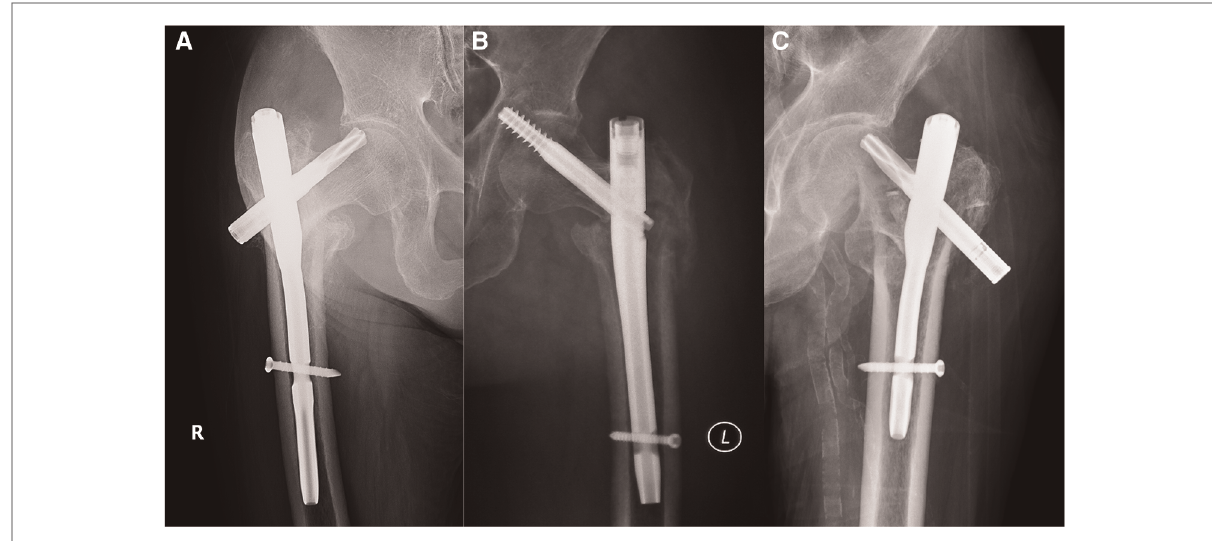
FIGURE 2 Types of implant failure. ( A ) Screw/blade cut out; ( B ) screw/blade perforation; ( C ) screw/blade back